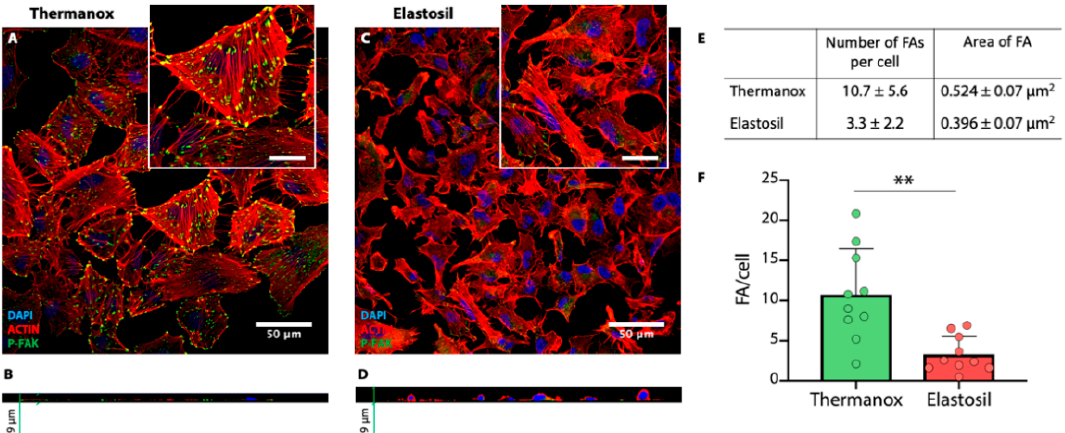
Figure 5. ( A – D ) Immunofluorescence images of A549 cells stained for F-actin (red) and focal adhesions (green) cultured on Thermanox™ Coverslips ( A , B ) and Elastosil ® Film ( C , D ) after 72 h of culture (magnification 40 × , inset scale bars represent 20 µ m). The sections on z-axis are reported in images B and D for Thermanox™ Coverslips and Elastosil ® Film respectively. ( E , F ) Quantification of focal adhesion observed on Thermanox™ Coverslips and Elastosil ® Film (** p < 0.01, n = 10).